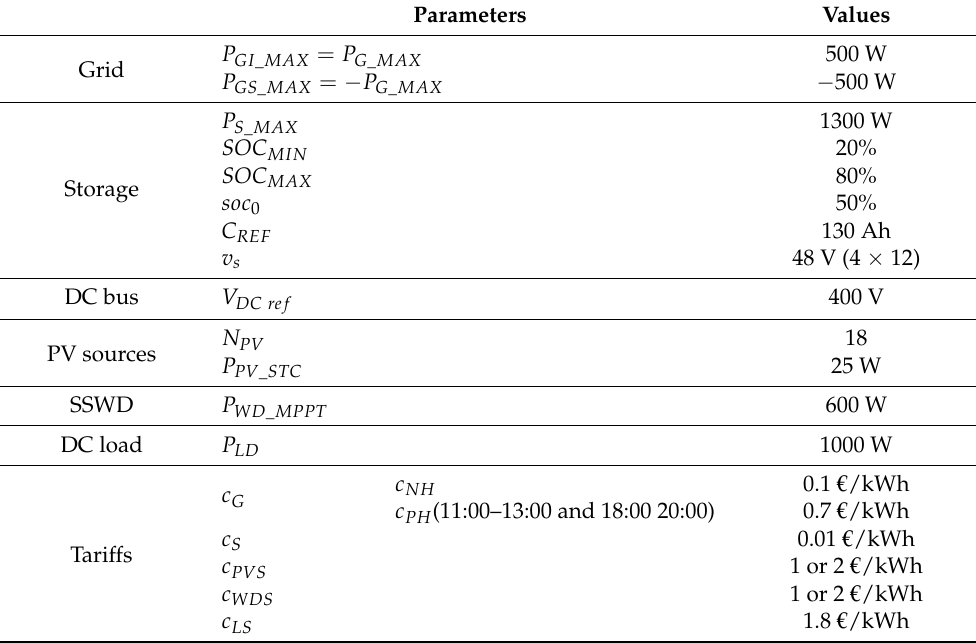
Table 1. Parameters for simulation